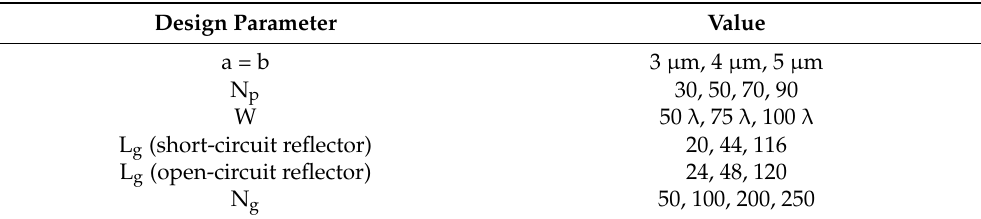
Table 1. Main design parameters of surface acoustic wave resonator